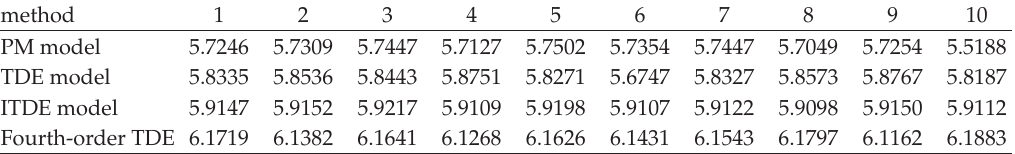
Figure 2: Graph of ISNR versus di ff erent damping coe ffi cient λ for “Barbara”. Table 1: ISNR (cid:3) in dB (cid:4) values for “license plate” image using random white Gaussian noise of variance σ (cid:7) 20.